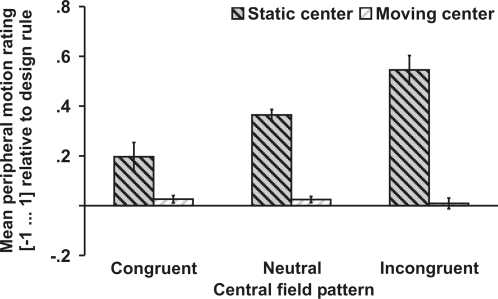
Externally versus self-induced retinal image slips (Exp. 4).Illusory peripheral motion was only perceived when the central field was static and was absent when the central field was moving. Error bars reflect within-subjects standard errors of the mean.